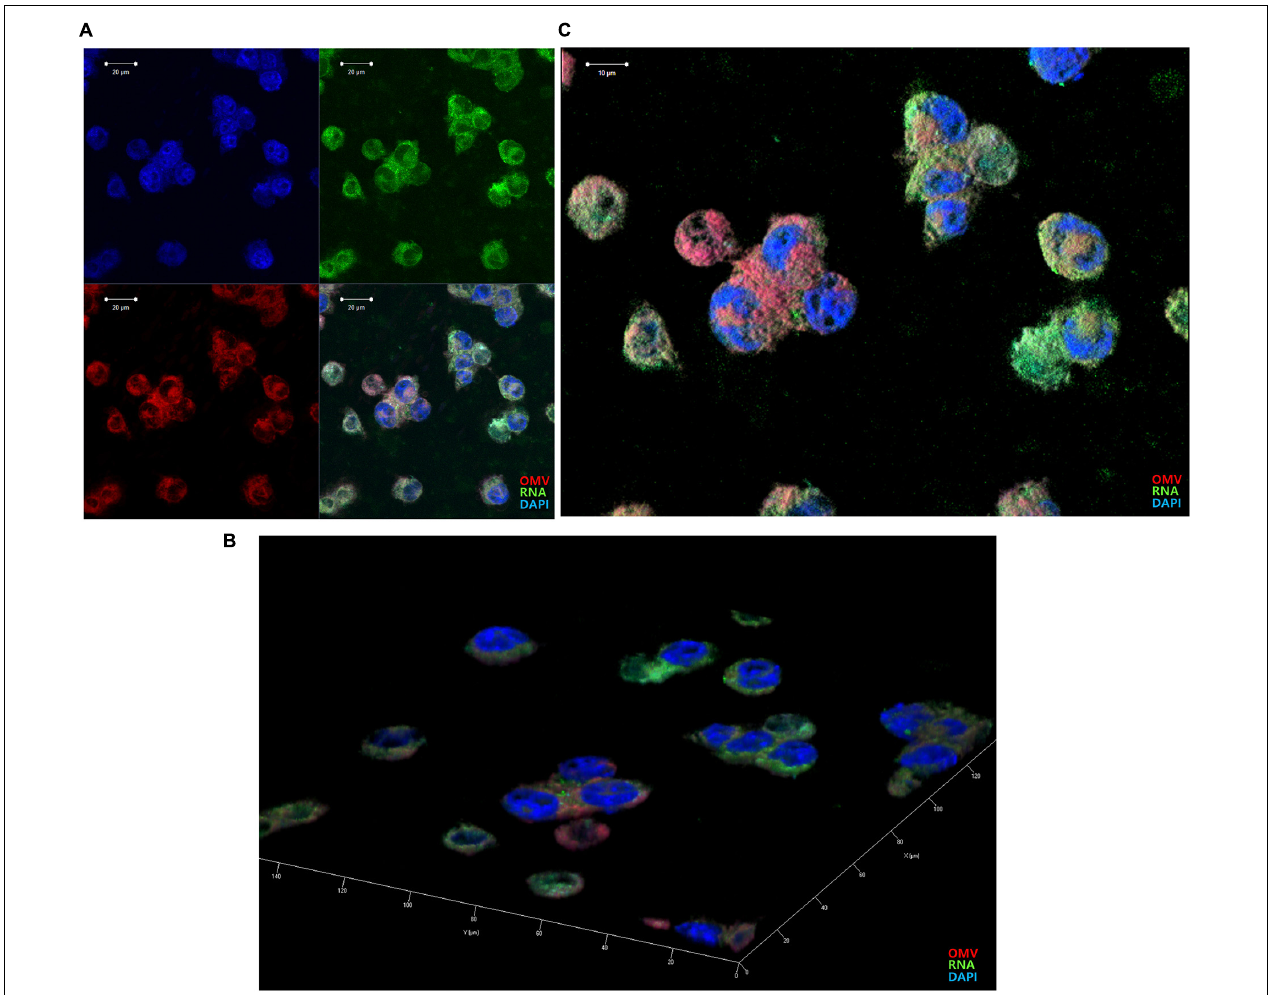
FIGURE 4 | Delivery of Aa OMVs and RNA into BV2 cells. Aa OMVs were prestained with the lipid tracer dye DiD (red) and RNA-specific dye SYTO RNASelect (green). Stained OMVs (approximately 4.5 × 10 8 particles) were incubated with BV2 cells on a chamber slide for 24 h at 37 ◦ C. DAPI was also counterstained with DAPI (blue) to visualize the nuclei. (A) Confocal microscopy analysis of Aa OMVs revealed colocalized OMVs and the RNA cargo inside (overlay). Bar = 20 µ m. (B,C) 3D rendering of confocal fluorescence images. Bar = 10 µ